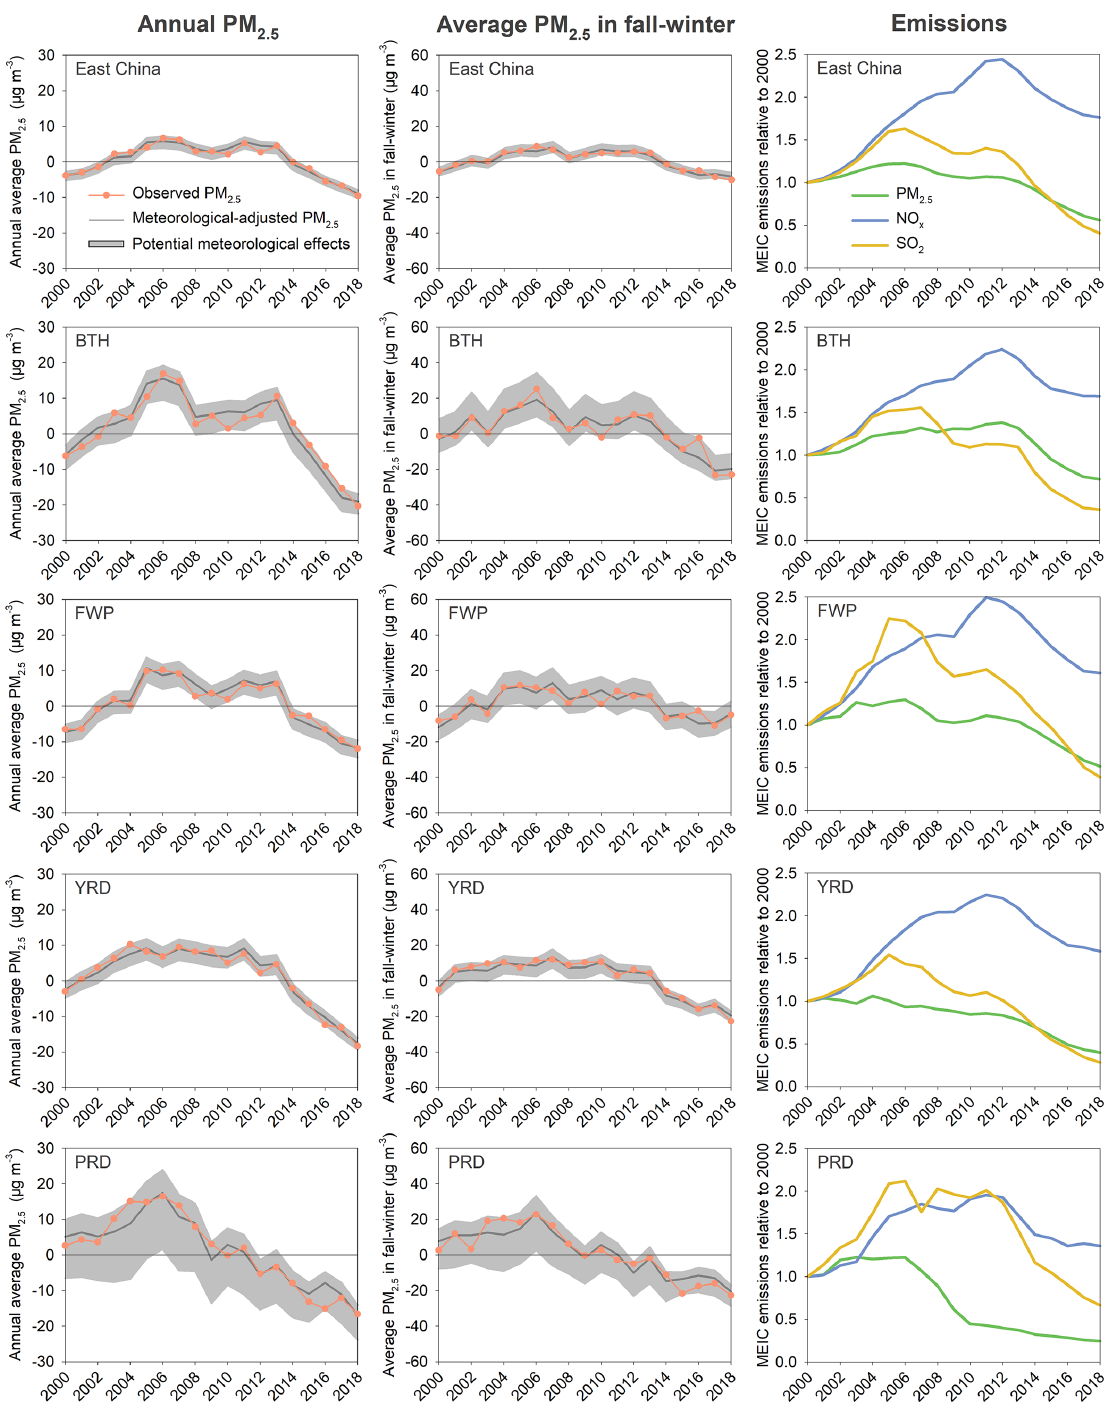
Figure 6. Time series of the annual average (left column) and fall–winter average (middle column) PM 2 . 5 concentrations before (the orange line) and after (the gray line) the adjustment of the meteorological effects from 2000 to 2018 using GAM. The gray shadow shows the potential range of the observed PM 2 . 5 due to meteorological effects. The right column shows the MEIC emissions of PM 2 . 5 , NO x , and SO 2 .